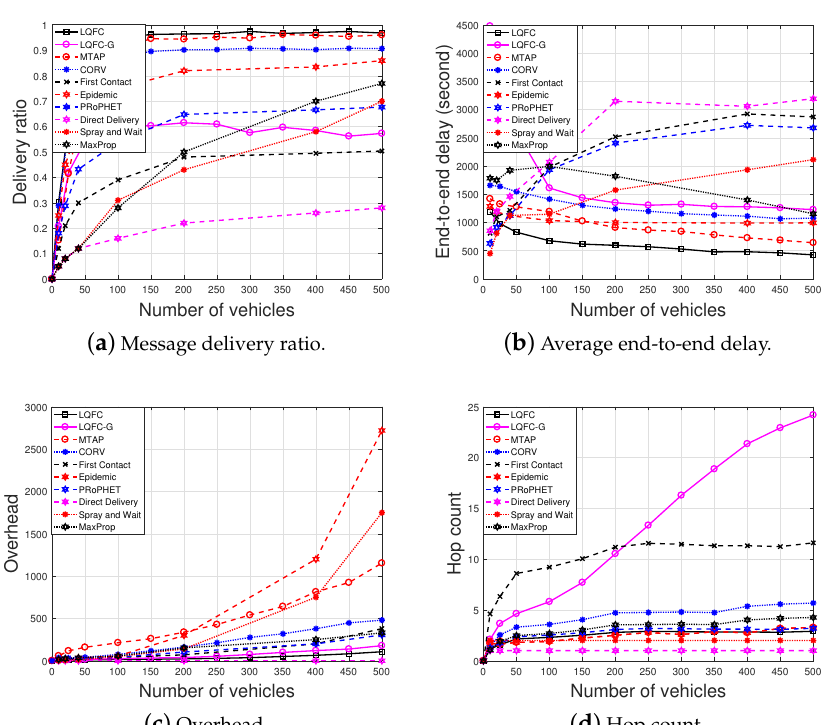
Figure 3. Network performance vs. number of